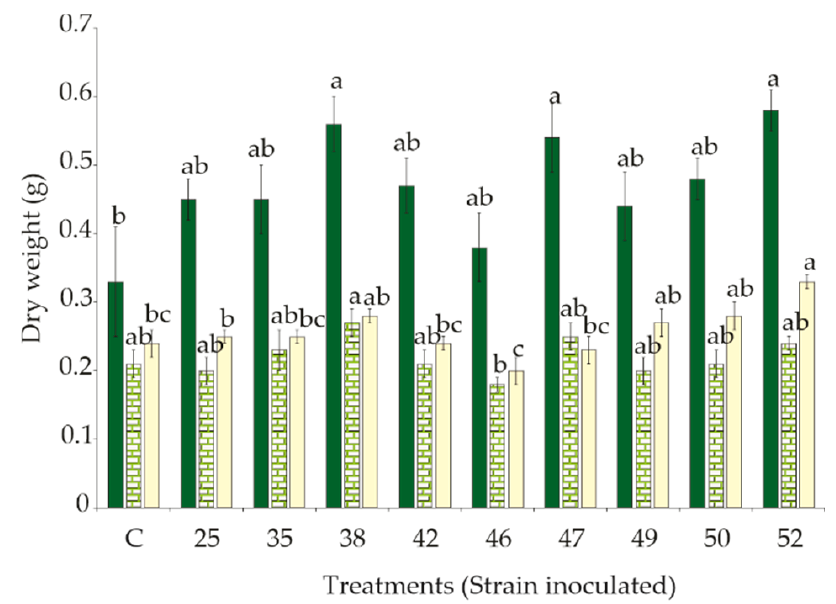
Figure 2. Effect of rhizobacteria strains on the root system of A. thaliana . Main root length (dark bars) and the number of secondary roots (light bars) were evaluated in vitro 20 days after germination in the presence of different bacteria strains. The number in each treatment corresponds to the number of each strain. Error bars represent the standard error. Letters over error bars indicate significant differences between the means ( n = 30) of the treatments using Tukey’s post hoc test ( p ≤ 0.05). Letter C refers to identical treatment of seeds and plants except for absence of bacterial inoculation.